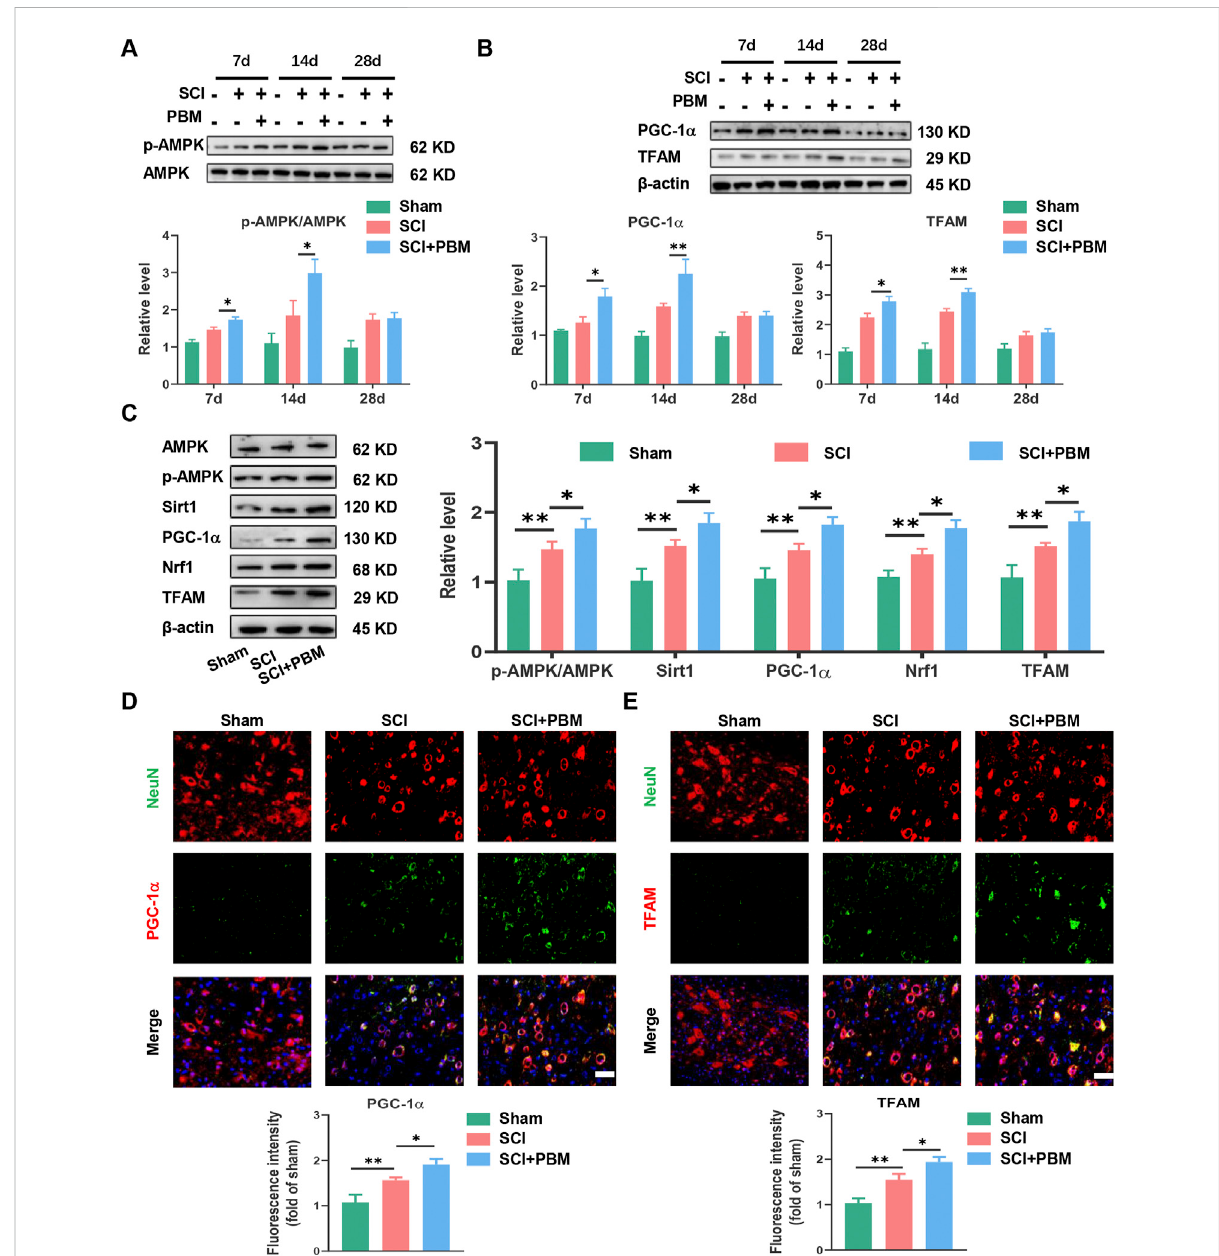
FIGURE 2 PBMactivatedtheAMPK/PGC-1 α /TFAMpathwayafterSCI. (A) :Westernblotanalysisandquanti fi cationofp-AMPK/AMPKexpressionlevelsat7, 14,and28 dpiineachgroup, n =3. (B) :Westernblotanalysisandquanti fi cationofPGC-1 α ,TFAMexpressionlevelsat7,14,and28 dpiineachgroup, n = 3. (C) : Western blot analysis and quanti fi cation of p-AMPK/AMPK, PGC-1 α ,TFAM, Sirt1, and Nrf1 expression levels in each group at 14 dpi, n = 3. (D) : Representative images of NeuN (red) and PGC-1 α (green) for each group at 14 dpi. Nuclei were stained with DAPI (blue). Quanti fi cation of theintensityofPGC-1 α relativetothatintheshamgroup,Scalebar:50 µm, n =3. (E) :RepresentativeimagesofNeuN(red)andTFAM(green)foreach group at 14 dpi. Nuclei were stained with DAPI (blue). Quanti fi cation of the intensity of TFAM relative to that in the sham group, Scale bar: 50 µm n =